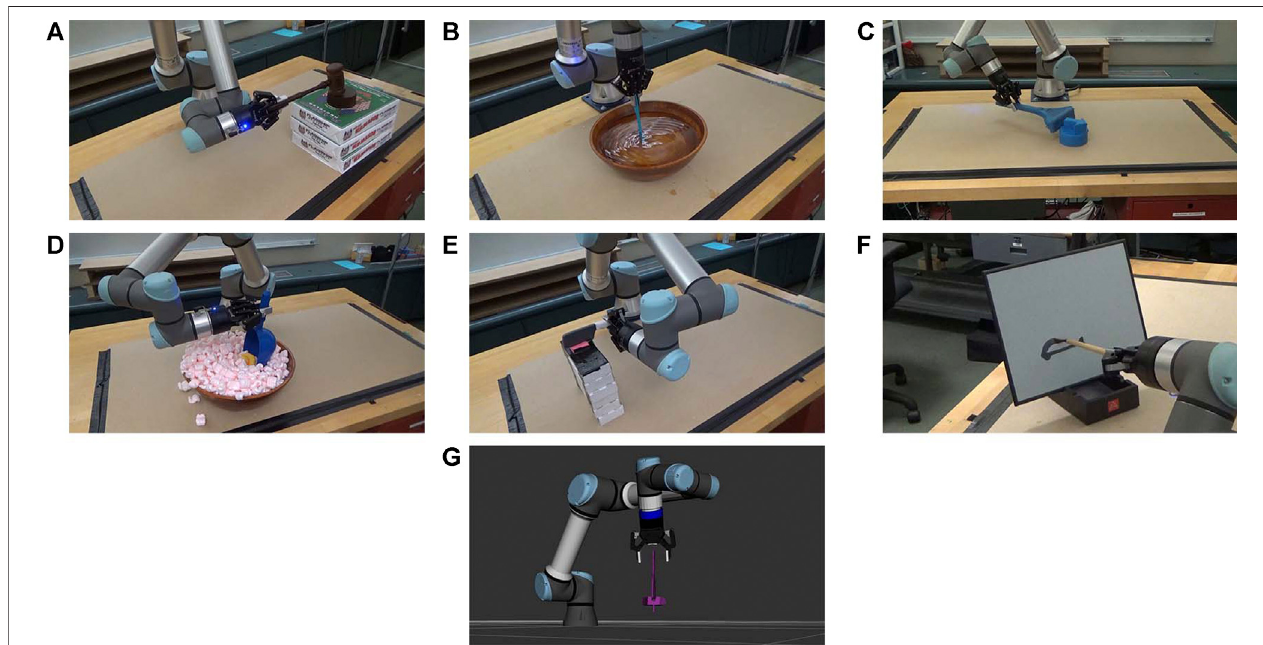
FIGURE 4 | Demonstration of the variety of tasks learned by the robots using source objects. Star 1 tested a robot learning a wide range of tasks, including (A) knocking, (B) stirring, (C) pushing, (D) scooping, (E) cutting, (F) writing, and (G) screw-driving.